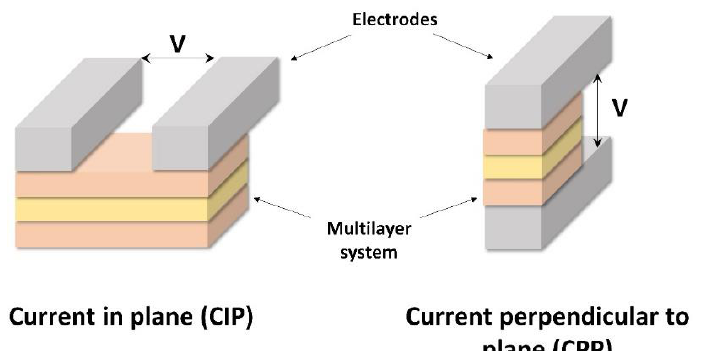
Figure 4. Schematic diagram of current in plane (CIP) configuration and current perpendicular to plane (CPP) configuration.